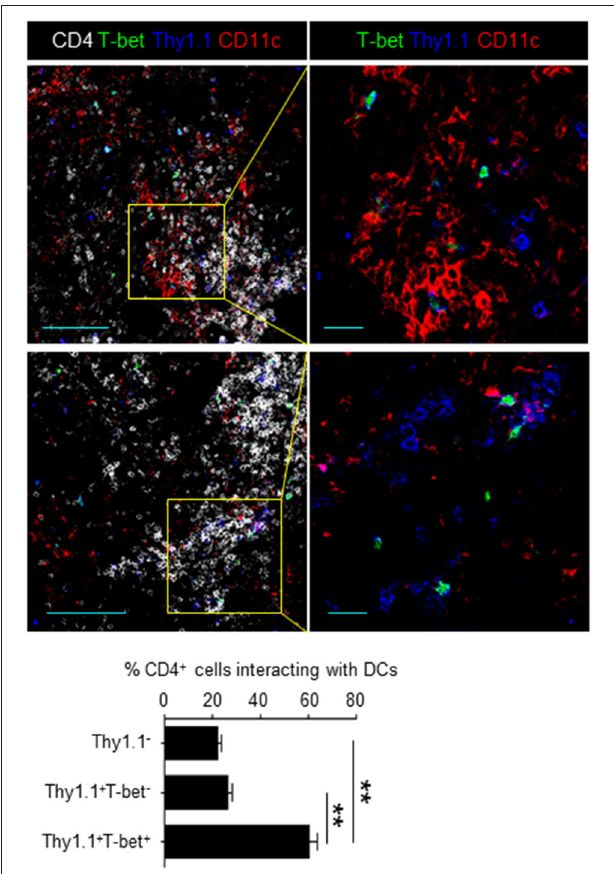
FIGURE 3 | Memory precursors preferentially contact DCs at the beginning of the contraction phase. Splenic sections from mice transferred with T-bet-ZsGreen (green) tg LCMV GP-specific CD4T cells and immunized were stained with anti-Thy1.1 (blue), anti-CD11c (red) and anti-CD4 (white). A bar chart represents the quantification of Thy1.1 − (endogenous CD4 + ), T-bet − Thy1.1 + and T-bet + Thy1.1 + cells in contact with CD11c + cells in the PALS. Scale bar, 100 µ m (left) and 20 µ m (right) n = 100–200. These data are representative of three independent experiments. Data are shown as mean ± SD. ** p <